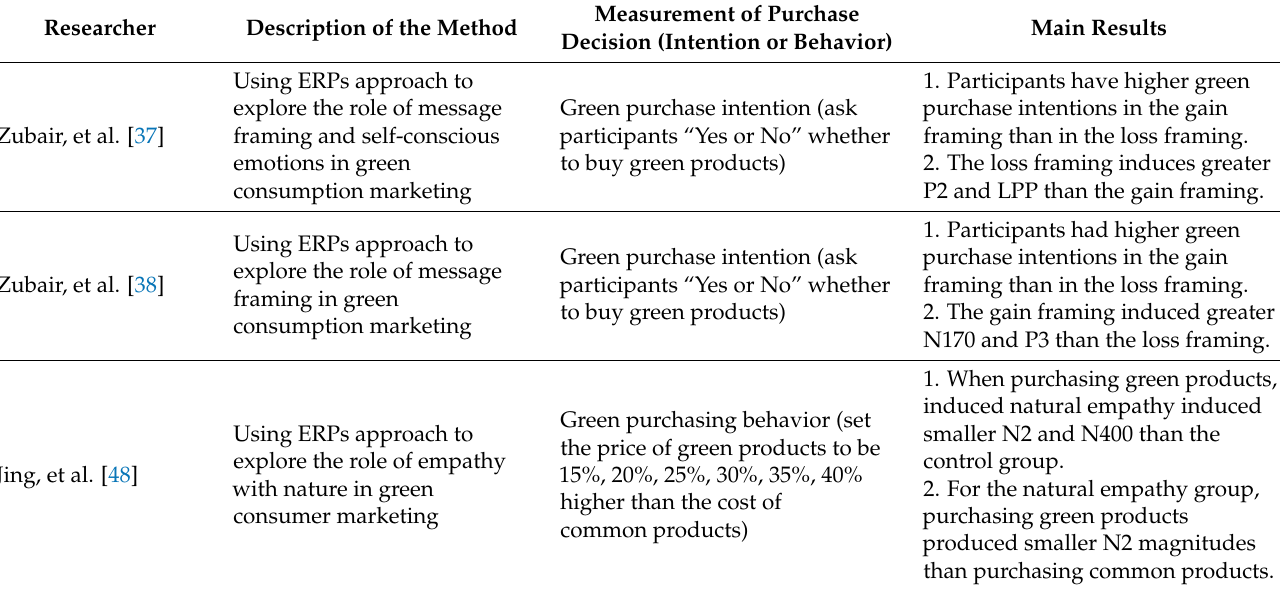
Table 2. A review of medical methods used for marketing